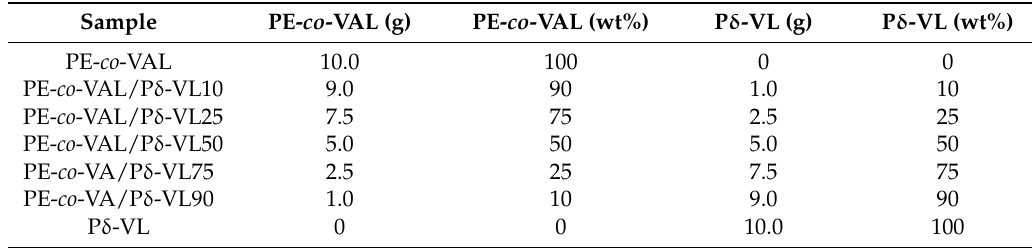
Table 1. Preparation conditions of PE- co -VAL/P δ -VL blends.